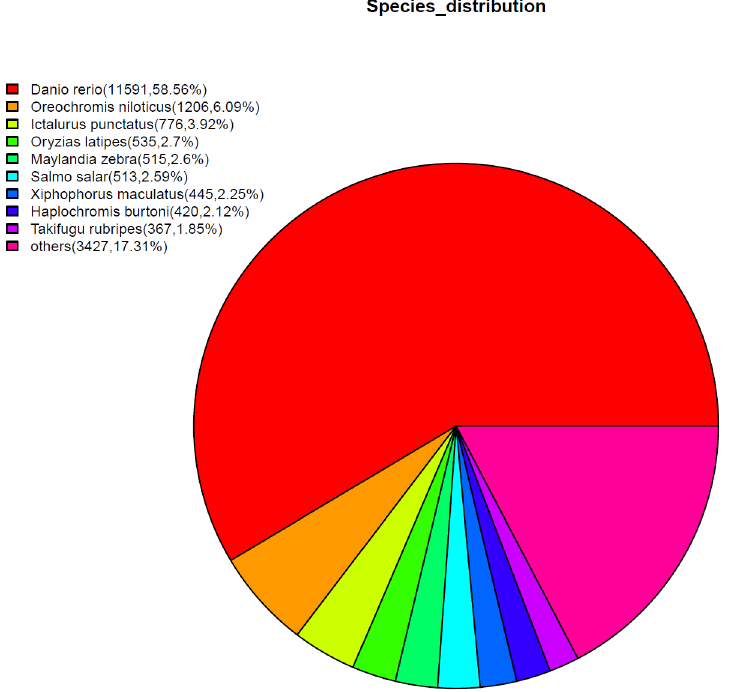
Fig 1. Species distribution of the top BlastX hits using the assembled unigenes of yellow catfish. The unigenes were searched against the NCBI Nr database with a cut-off E-value < 1e-5.